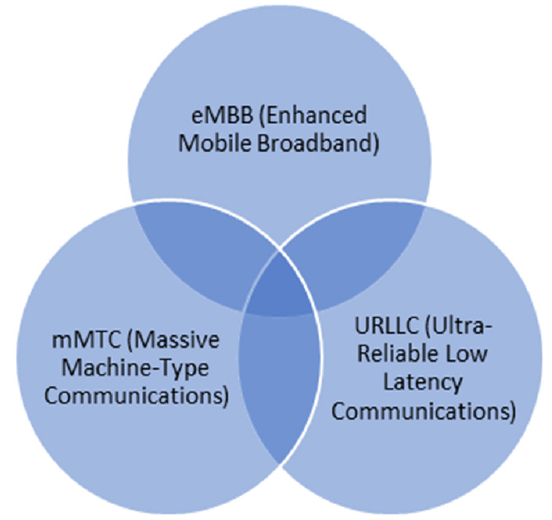
Figure 1. Achievements in Industry 4.0 with 5G and 6G.